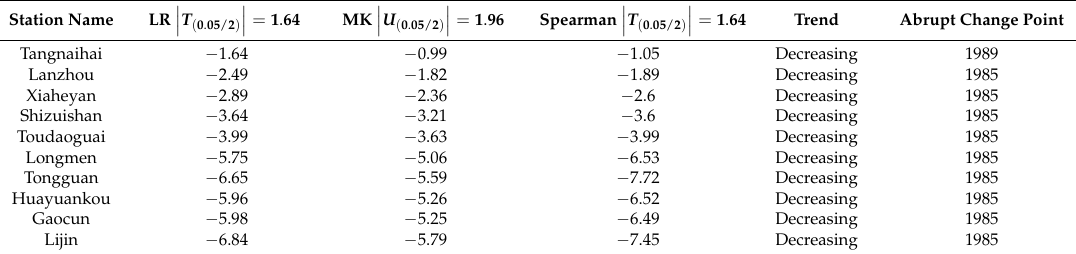
Table 2. Trends of annual streamflow of ten stations along the Yellow River from 1956 to 2016.